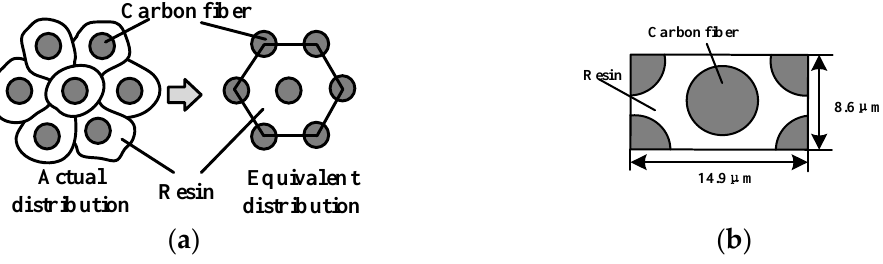
Figure 2. The schematics illustration of carbon fiber distribution processing: ( a ) CFRP microscopic arrangement; ( b ) definition of the equivalent section of the element body, preserving the geometry and the volume fraction of fiber to matrix.